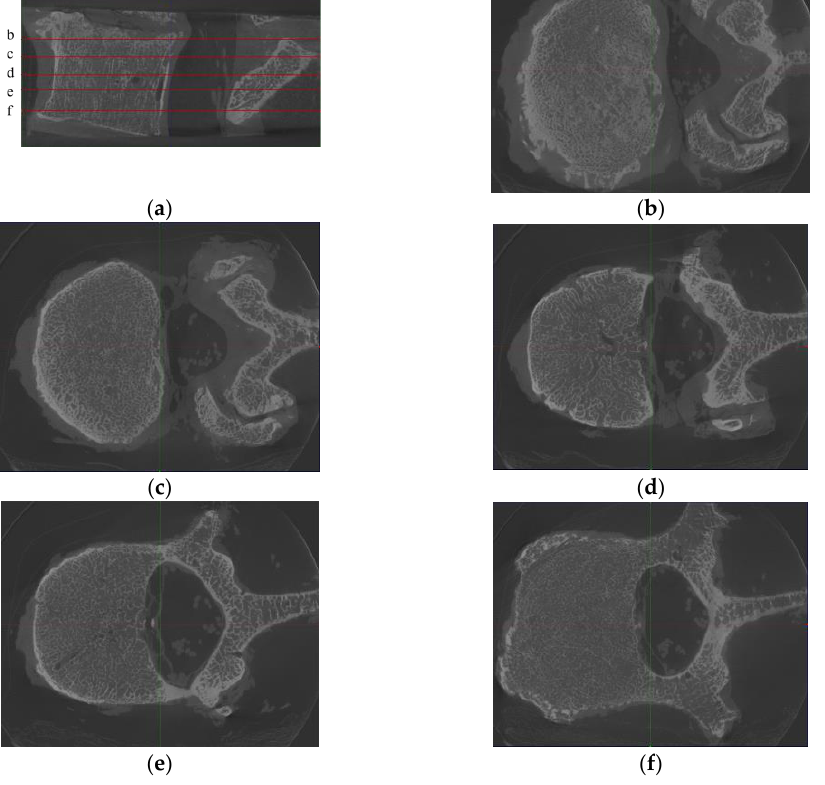
Figure 2. Samples from one L2 vertebra, where ( a ) is the sagittal position image of the L2 vertebra, with 5 noted slices (named b – f ), and ( b )–( f ) are the corresponding axis position images. We found that although the images were from the same vertebra, the differences between the images of different slices were substantially large. Moreover, since the technique used in this paper is an image-to-image technique, there is no longer a holistic concept of “vertebra” in the training process but only discrete images.